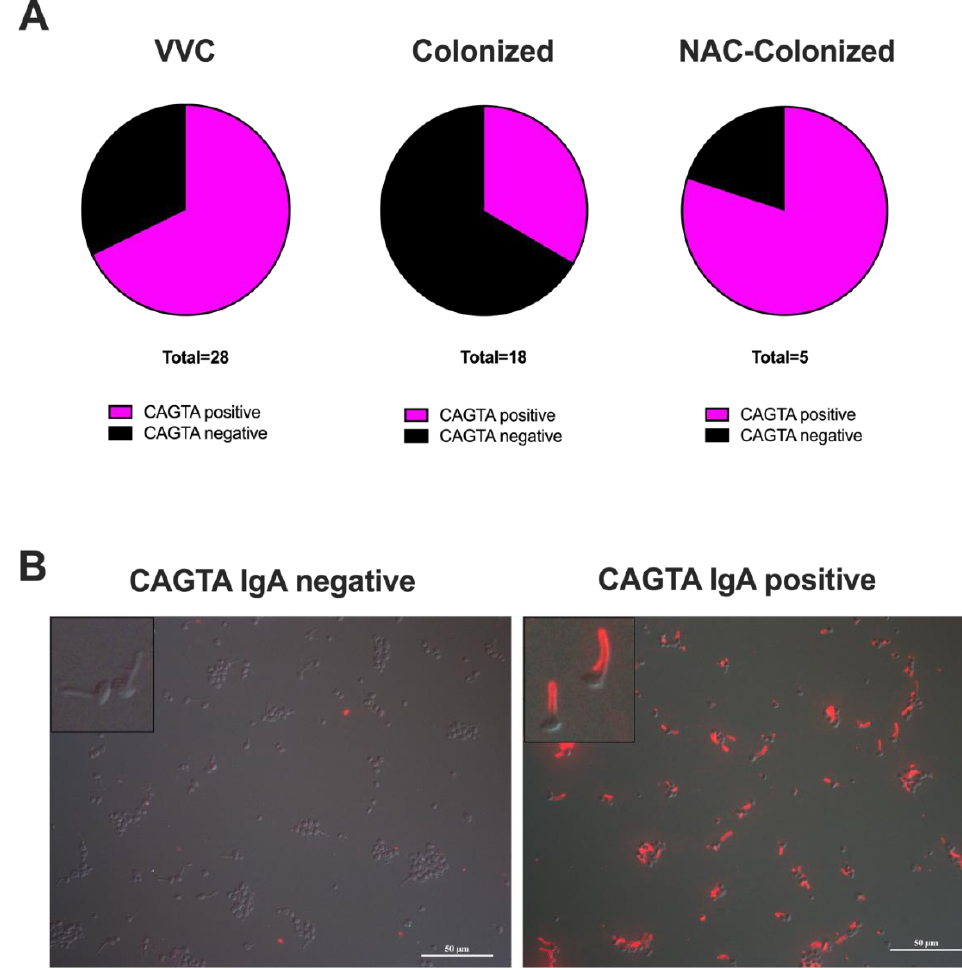
Figure 2. C. albicans germ tube antibody (CAGTA) IgA determination. ( A ): Pie charts of CAGTA IgA in positive (magenta) and negative (black) samples from VF of VVC women and C. albicans - or NAC-colonized women. ( B ): Representative images from samples with no CAGTA IgA (colonized women: CAGTA IgA negative, SP-8605) and with CAGTA IgA (VVC women: CAGTA IgA positive, SP-4900). The Candida cells shown are used to capture specific CAGTA and are part of the analysis kit. Magnification = 40X; scale bar = 50 μm.